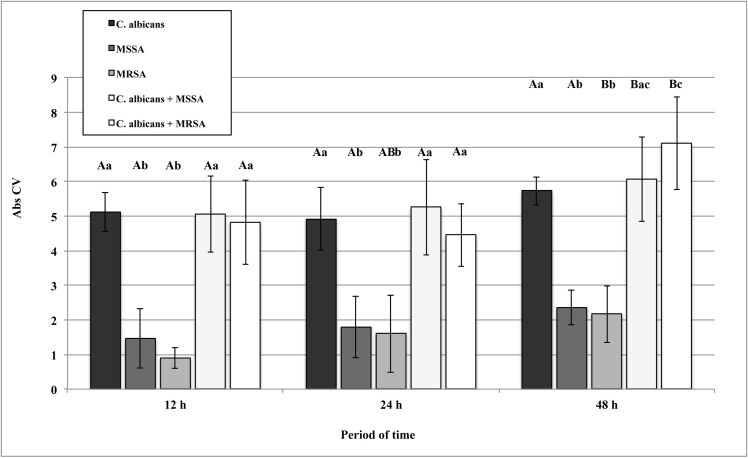
Absorbance values of CV solutions (Abs CV) obtained from biofilms of C. albicans, MSSA, and MRSA as single- and dual-species grown in RPMI at 37°C.Error bars represent standard deviation. The uppercase letters show differences among time periods and lowercase letters show differences among the growth conditions (Tukey post-hoc test at ρ>0.05).